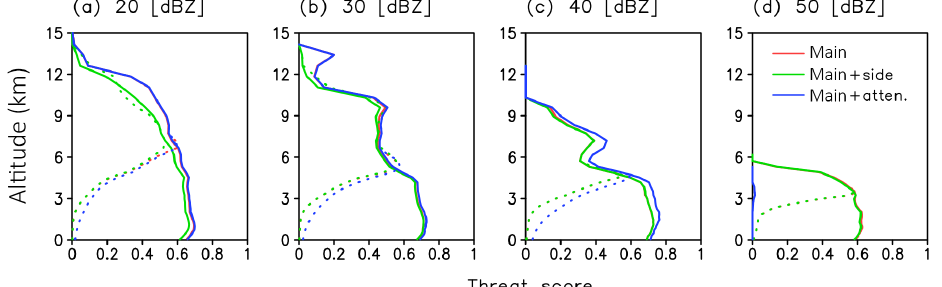
Figure 15. Threat scores with thresholds of (a) 20, (b) 30, (c) 40, and (d) 50 (dBZ) for bw20bs05. The red line overlaps the blue line for (a) , (b) , and (c) and the green line for (d) . The dotted and solid lines show the threat score with and without considering the impact of surface clutter,